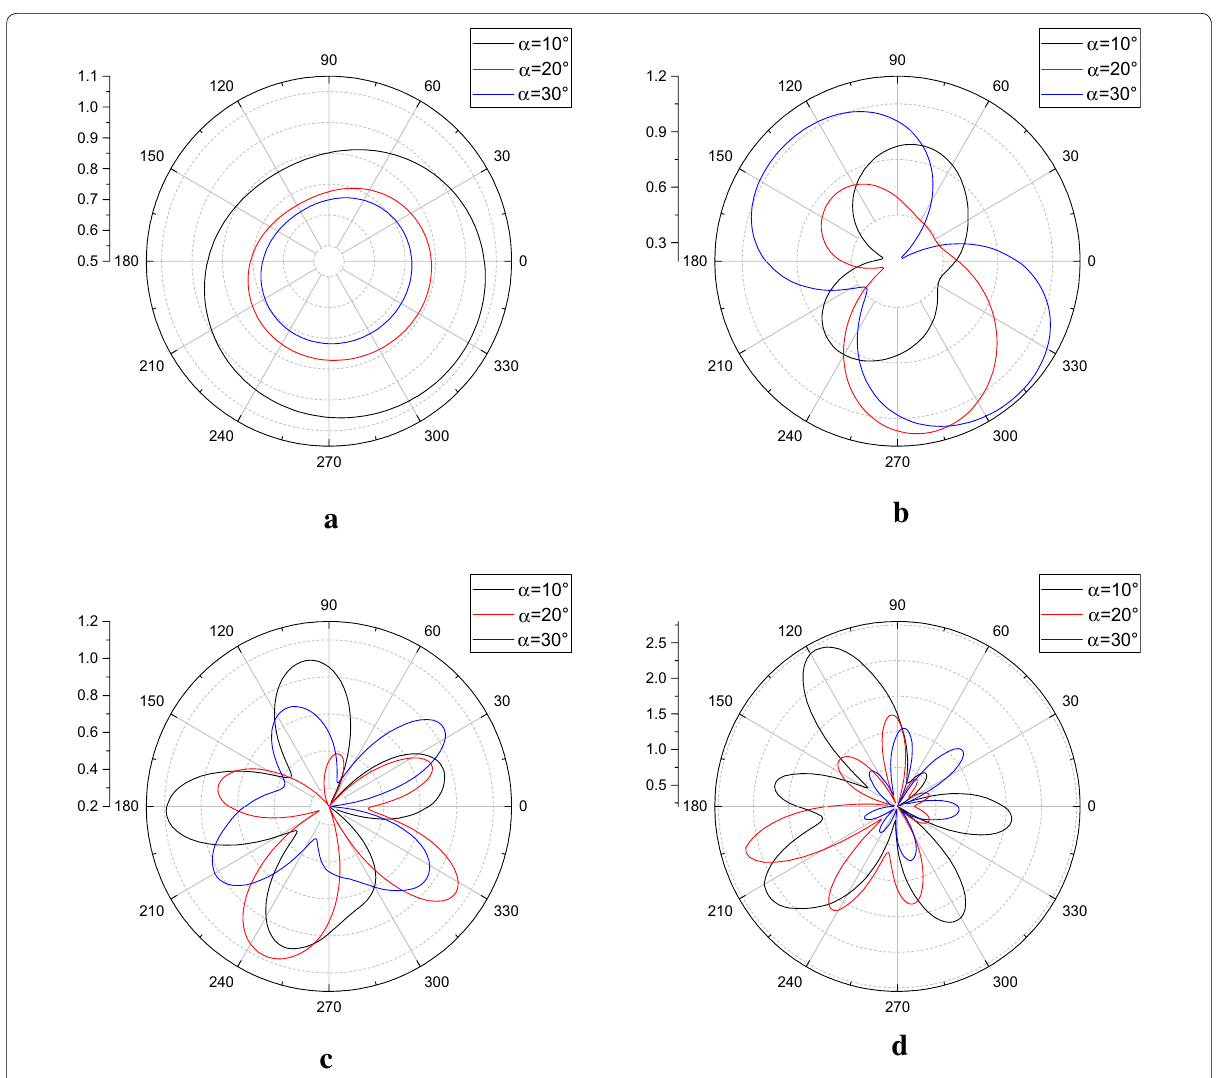
Figure 4 Angular distribution of scattered pressure of array plane wave versus ka (incident angles α are 10°, 20°, and 30°, and array number is 16): a ka = 0.5 , b ka = 1.8 , c ka = 3.0 , and d ka =